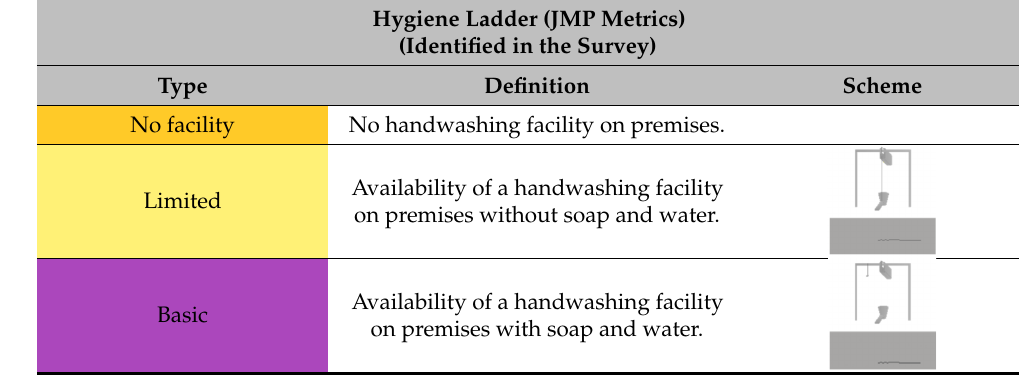
Table 2. Classification of each type of the handwashing situation and its level within the hygiene